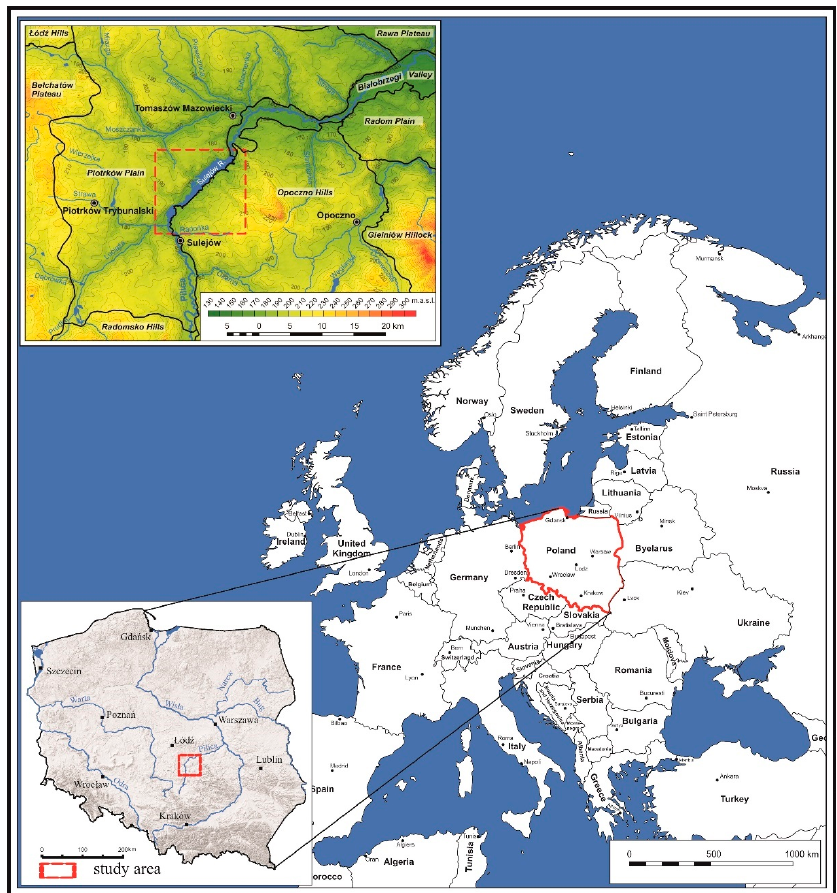
Figure 1. Location of the Sulejów Reservoir.